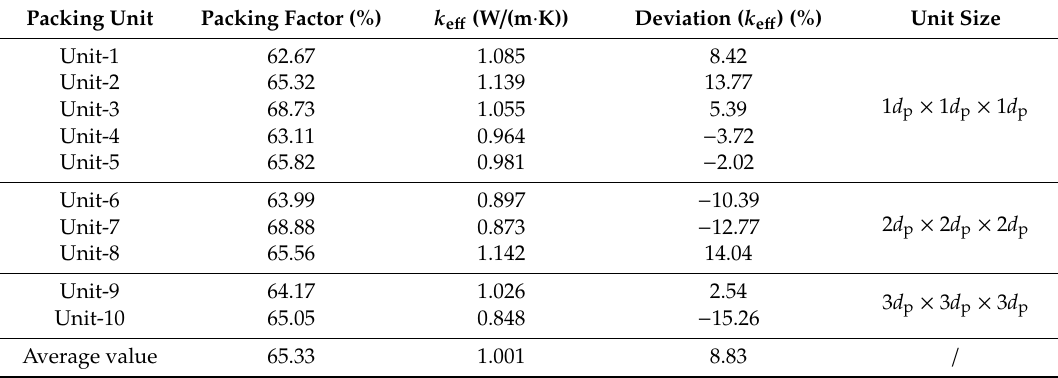
Table 3. E ff ective thermal conductivities for random packing units ( T = 1123.15 Table 3. Effective thermal conductivities for random packing units ( T = 1123.15 K).